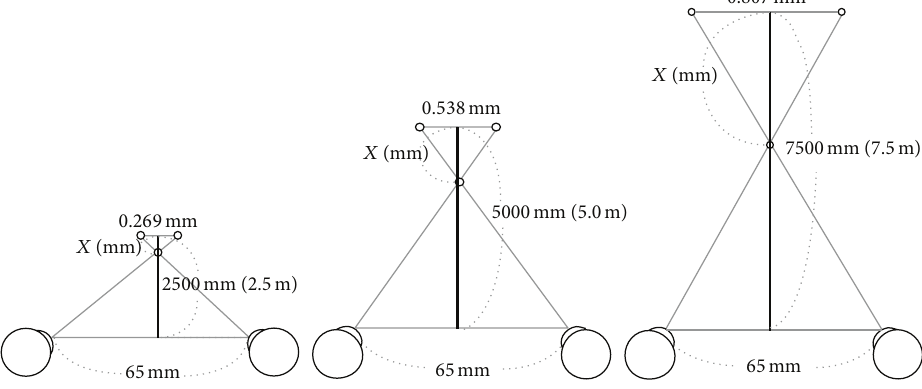
Figure 4: The calculation method for the projection